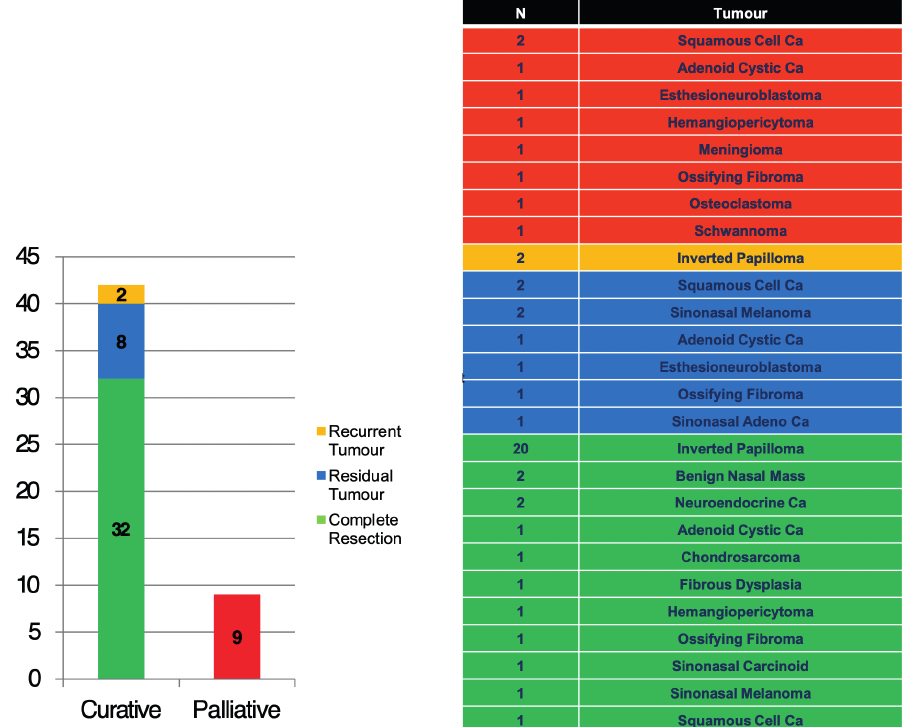
Figure 1. Curative Surgery (n=42), Palliative Debulking (n=9), 2 years